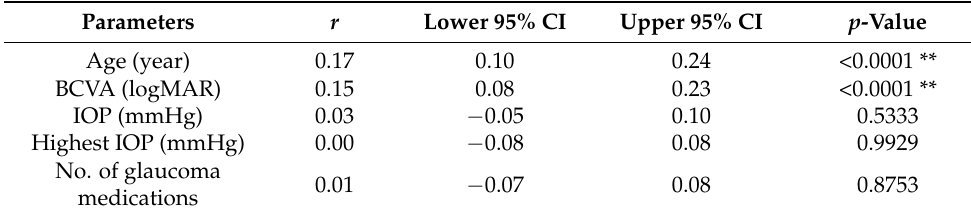
Table 4. Possible associations among AGEs and various continuous parameters.